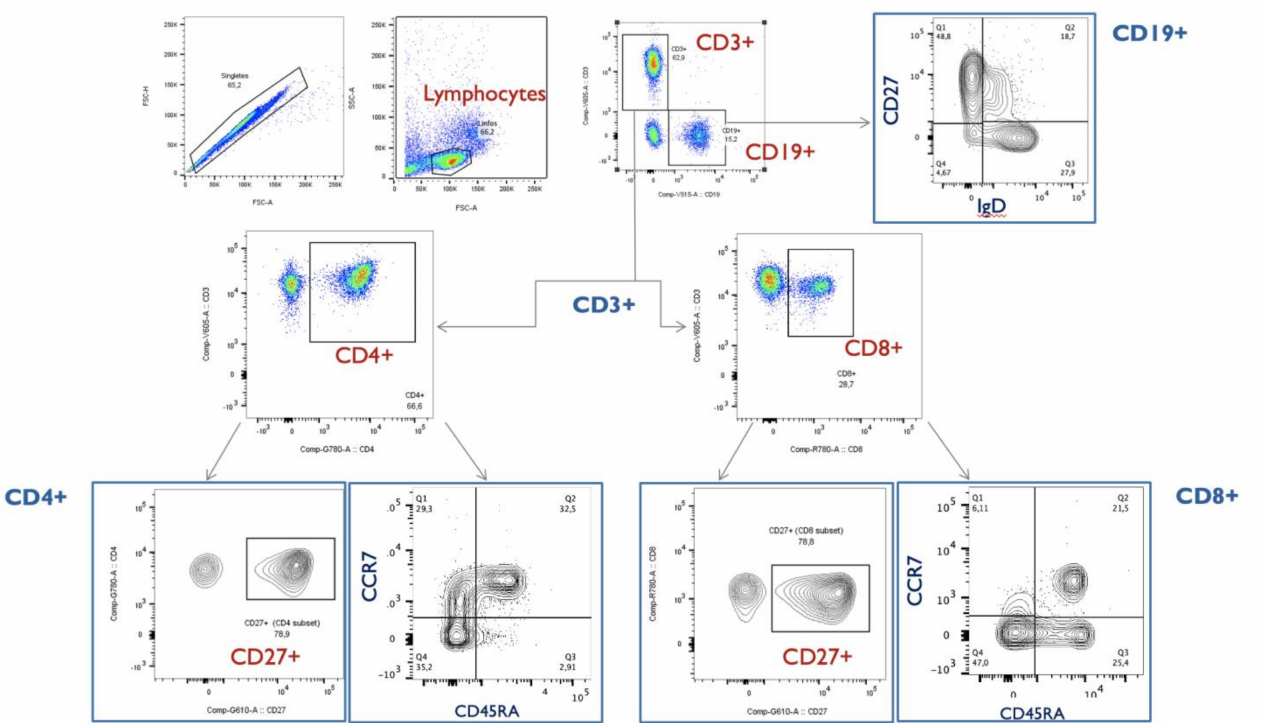
Figure A2. Analysis strategy of the PBMCs